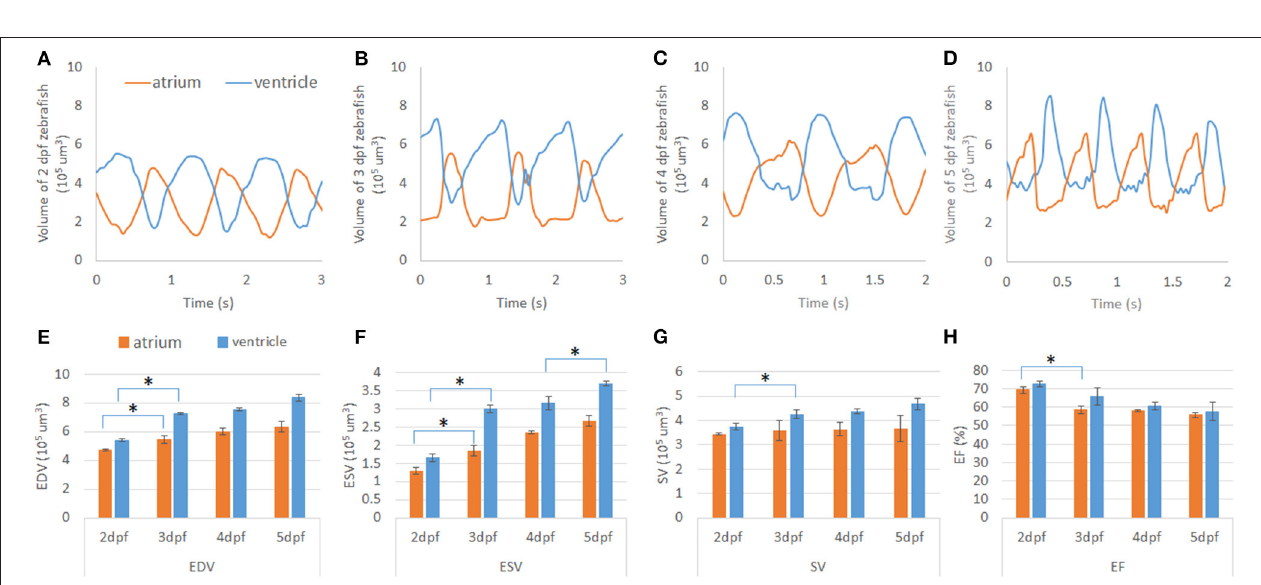
FIGURE 5 | Representation of the contraction to dilation of zebrafish heart volume change over time. (A) Autosegmented successfully reconstructed 4D image captured the rough inner surface of zebrafish due to trabeculation after merging with fluorescent-labeled tg ( cmlc2:gfp ) zebrafish from light-sheet fluorescent microscopy (LSFM) images. (B) Volume change in the ventricle and atrium was measured from autosegmentation. Total volume of atrium and ventricle represented around 9.5 × 10 5 µ m 3 when zebrafish was at 4 dpf.